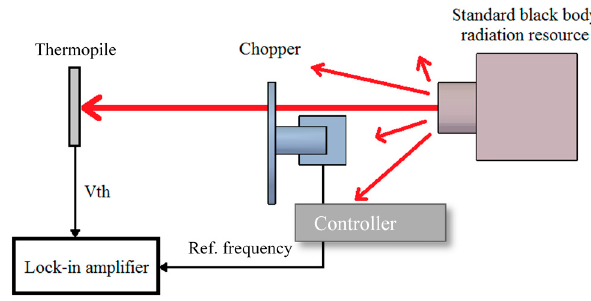
Figure 11. Measurement of the frequency response for the thermopiles.